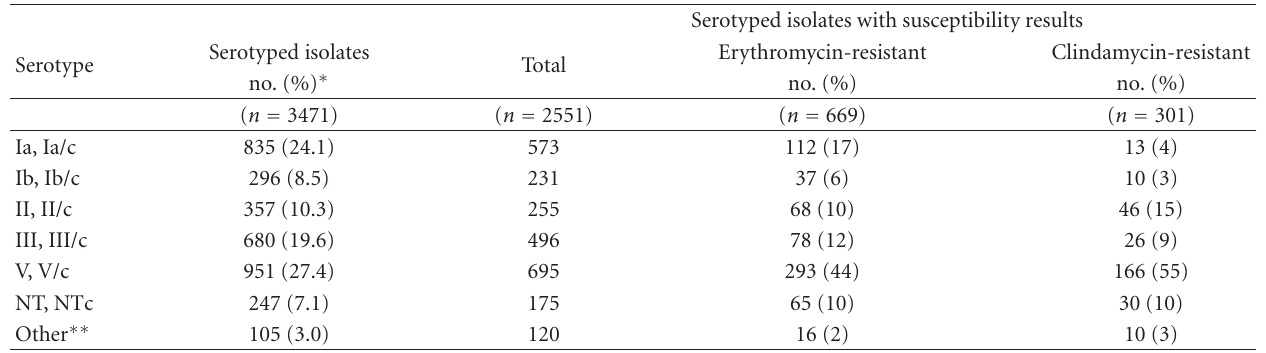
Table 1: Distribution of serotypes and resistance to erythromycin and clindamycin among invasive group B streptococcus isolates. Serotyped isolates with susceptibility